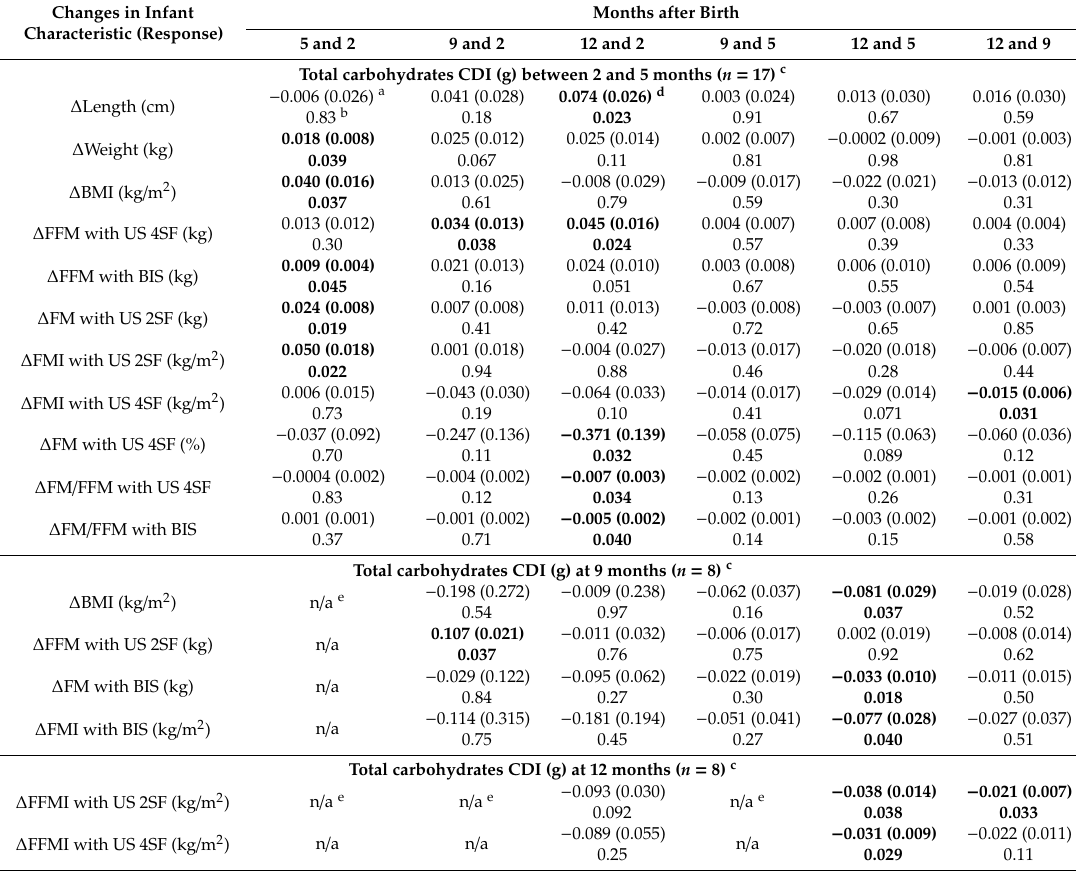
Table A3. Associations of calculated daily intakes of total carbohydrates at the time points with changes in infant body composition between the time points.